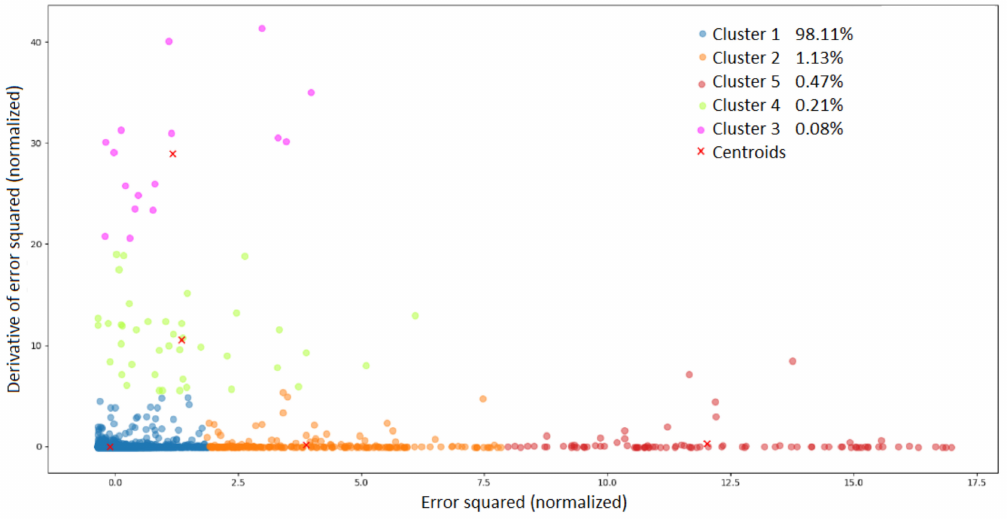
Figure 6. Cluster map for the autoregressive method K-means anomaly